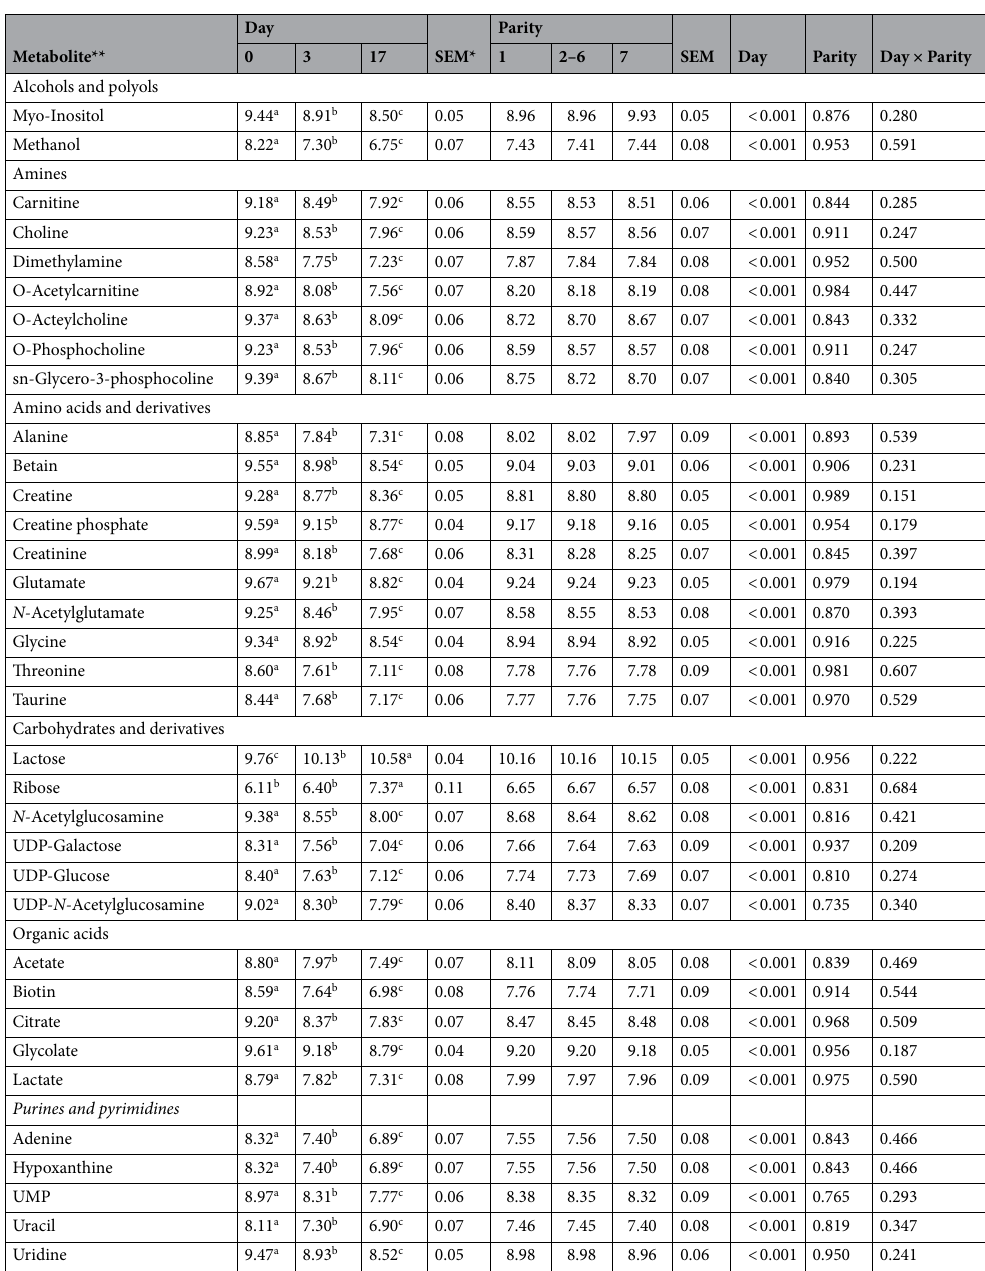
Table 2. Effect of lactation stage and parity number on non-volatile polar metabolite profiles of sow colostrum and milk. abc Different superscript letters within row indicate significant differences ( P < 0.05). *Greatest standard error of the mean (SEM). **Metabolite contents are expressed as log10 [peak area of respective compound in arbitrary